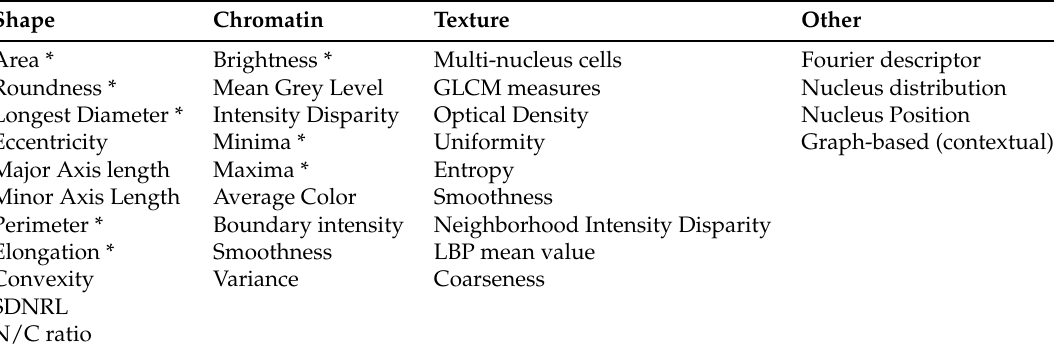
Table 5. Summary of commonly used image features for cervical cell classification. Some of the features represent more high-level concepts, for its measures and respective extraction we refer to some of its implementations [32,54,61,73,74,140,142,143]. N/C (nucleus/cytoplasm; GLCM (grey-level co-occurrence matrix); SDNRL (standard deviation of the normalized radial length). LBP (local binary pattern). * These characteristics are extracted for both nucleus and